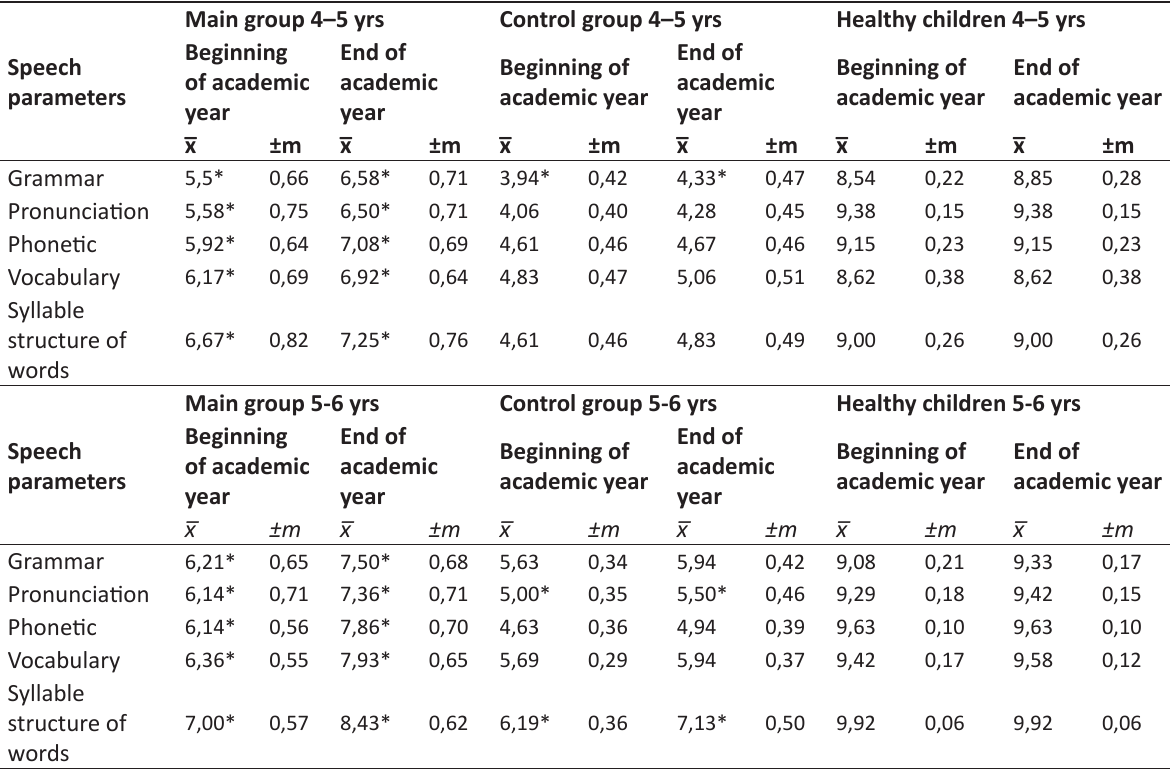
Table 4. Speech diagnostic of 4-6 yrs children with speech disorders and healthy